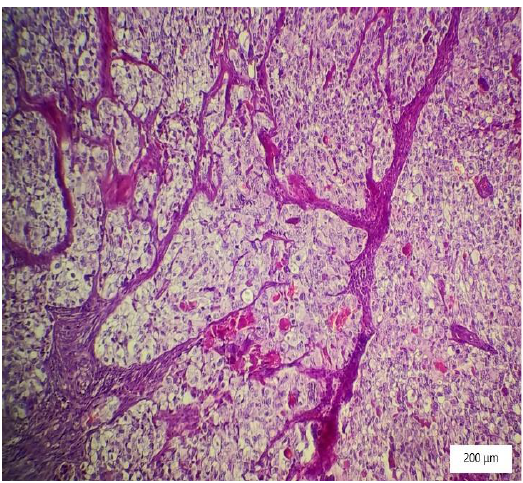
Figure 3. Tubulocystic pattern of tumor cells with clear cytoplasm, inflammatory infiltrate, necrosis, and hemorrhagic areas (HE ×100).